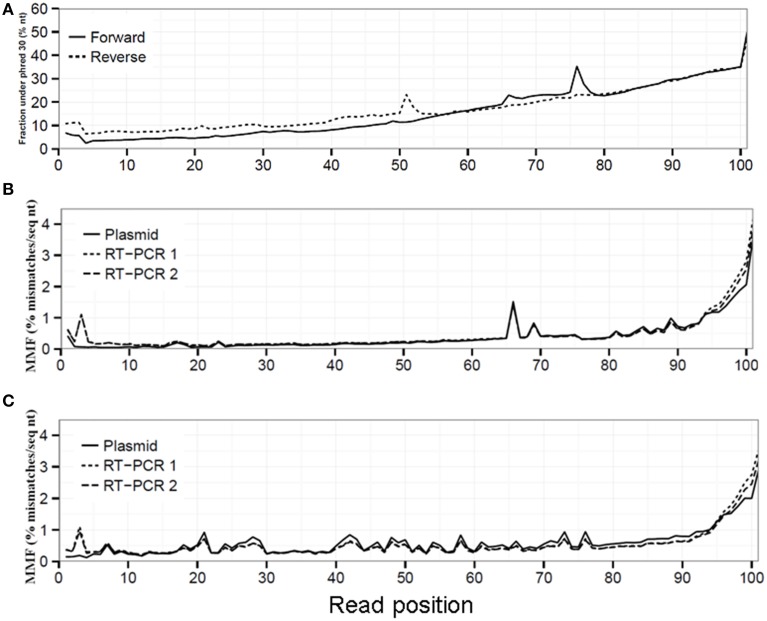
Sequencing quality decreased toward the 3′ read end displayed by an increased fraction of sequenced nucleotides with a phred ≤30 (A). This reduced sequencing quality led to an increased MMF in both the forward (B) and reverse (C) run for the plasmid, RT-PCR 1 and RT-PCR 2 datasets.